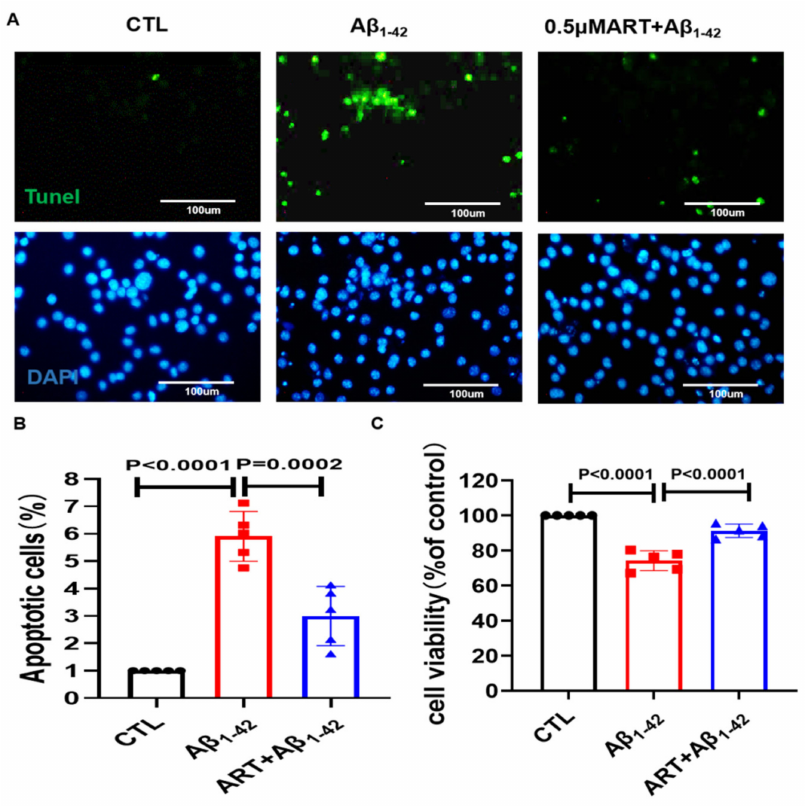
Figure 4. Artemisinin-pretreated microglia medium reduced PC12 cell damage. ( A ) Tunel staining was performed to check the protective effect of Artemisinin pretreated microglia medium on PC12 cells. ( B ) Quantification of apoptotic cells in ( A ). ( C ) Cell viability was detected by MTT assay. p < 0.05 was considered significantly